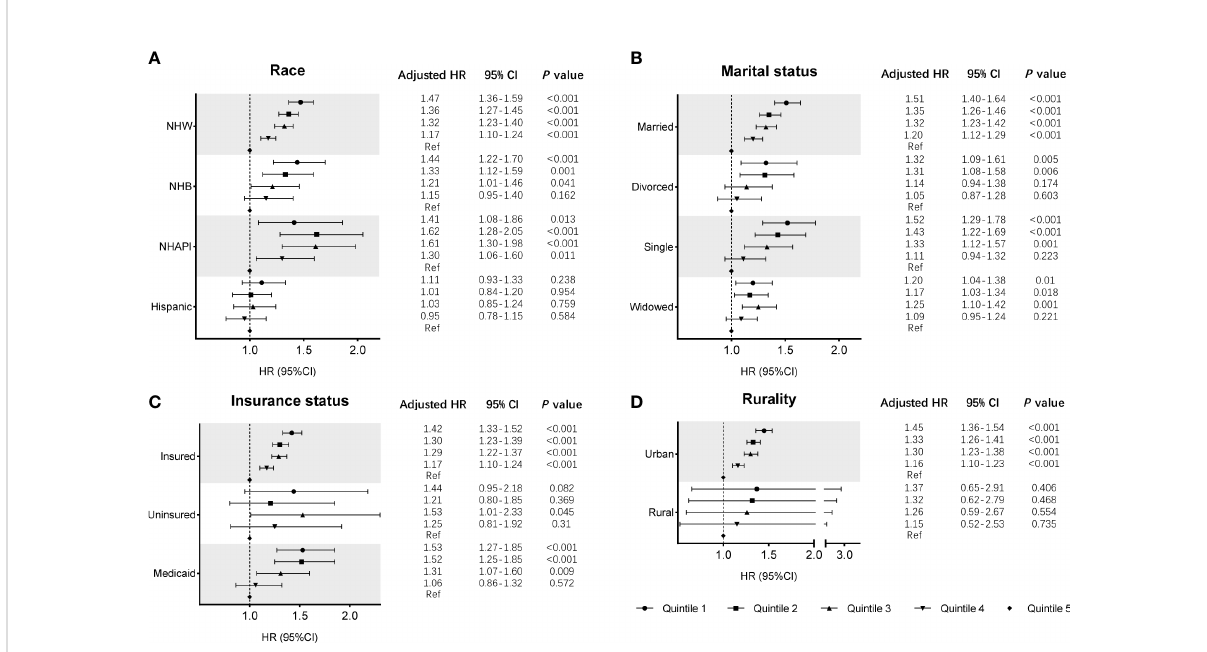
FIGURE 2 Subgroup analyses of the effects of SES on MSS in the SEER cohort, according to the subgroups of (A) race, (B) marital status, (C) insurance status, and (D) rurality, using multivariate Cox regression analysis with adjusted